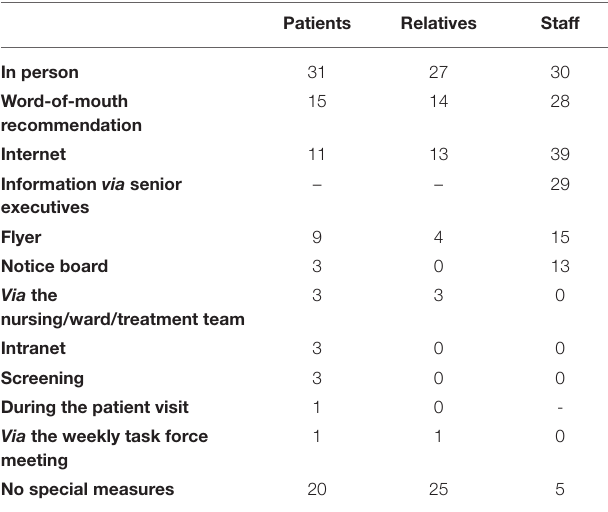
TABLE 3 | Ways of communication with the different target groups about COVID-psyCare services (absolute